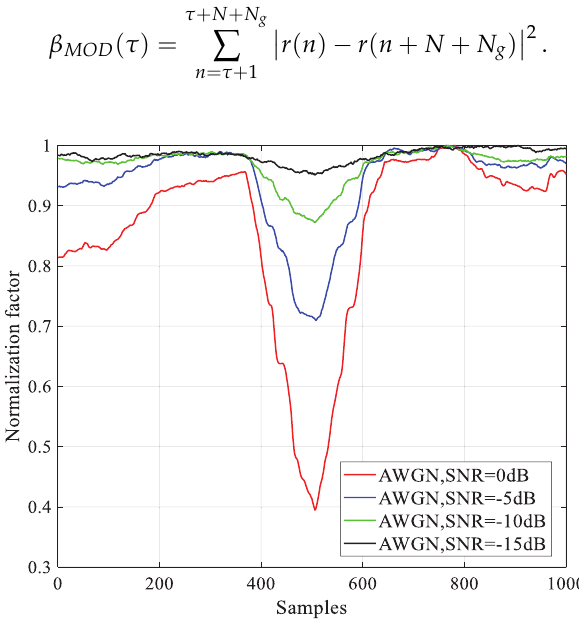
Figure 4. Comparison of MOD normalization factors at different